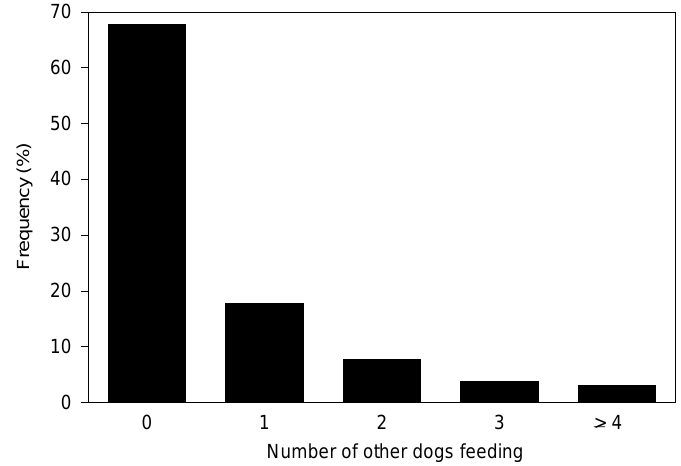
Figure 7. The numbers of other dogs feeding with the focal animal at each of the 689 meals.